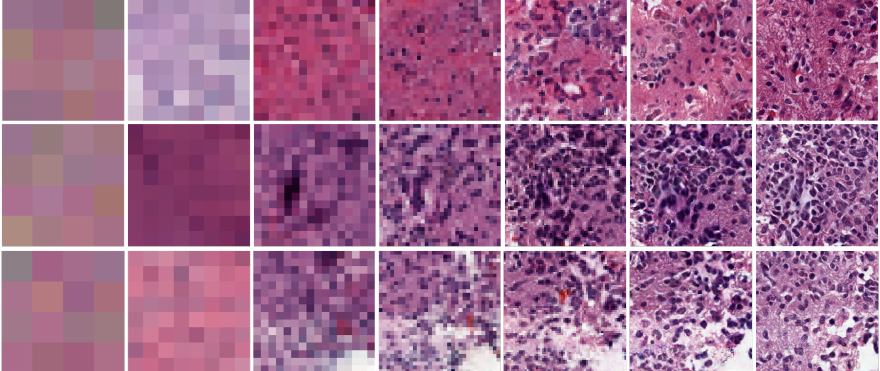
Figure 5. The embedding feature concatenation method and the layer structure of the generator of the generation module.